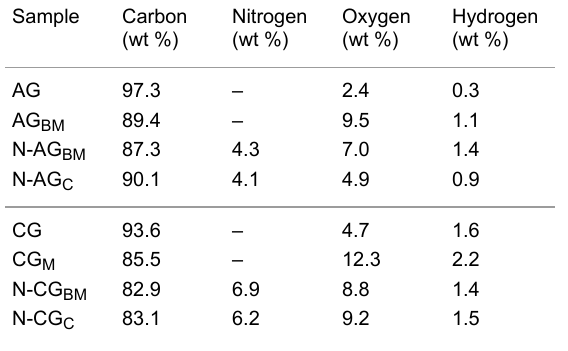
Table 1: Chemical composition determined by elemental analysis.